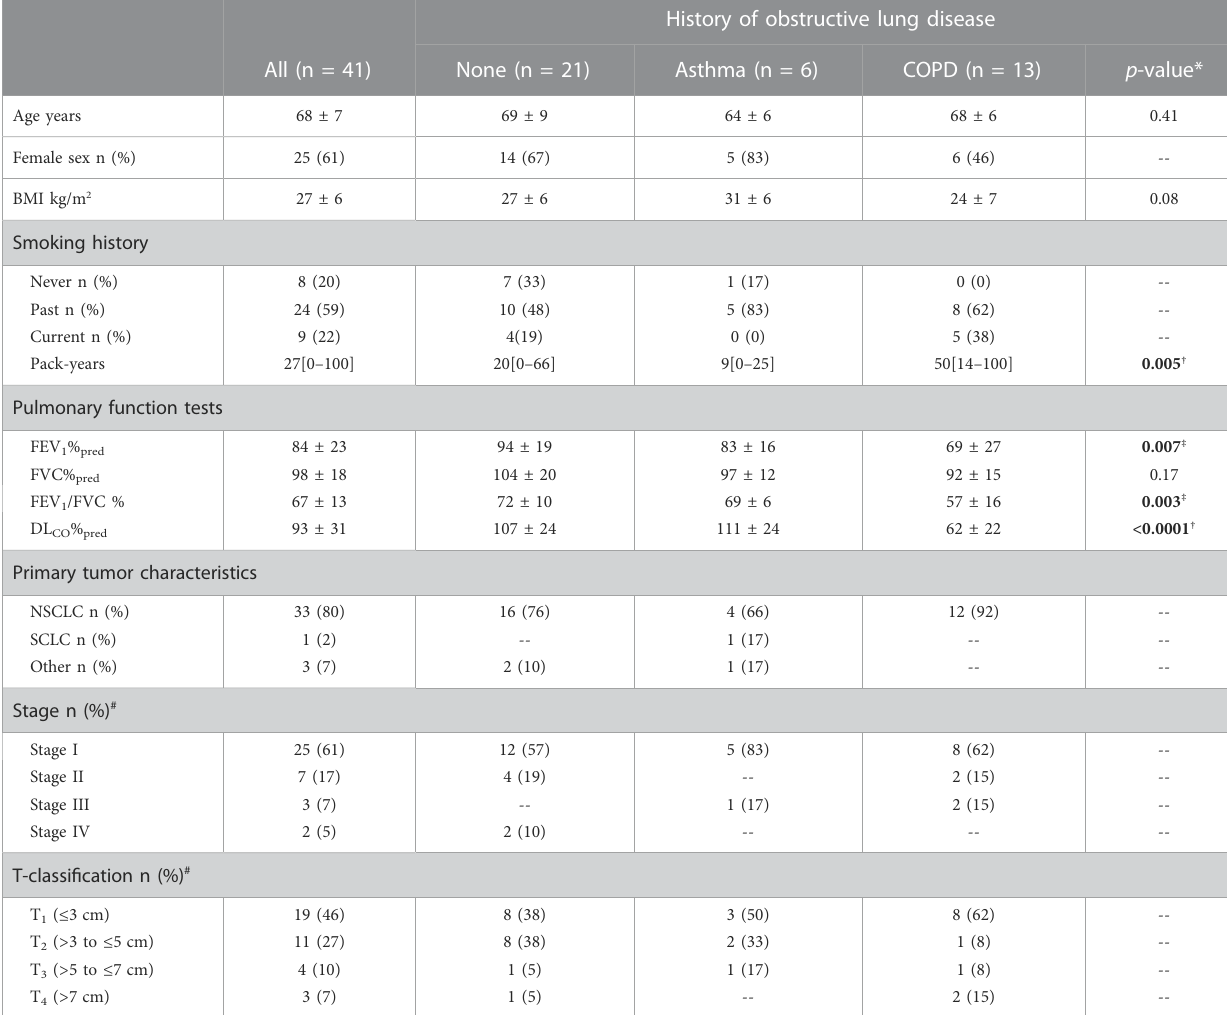
TABLE 1 Participant demographics and clinical